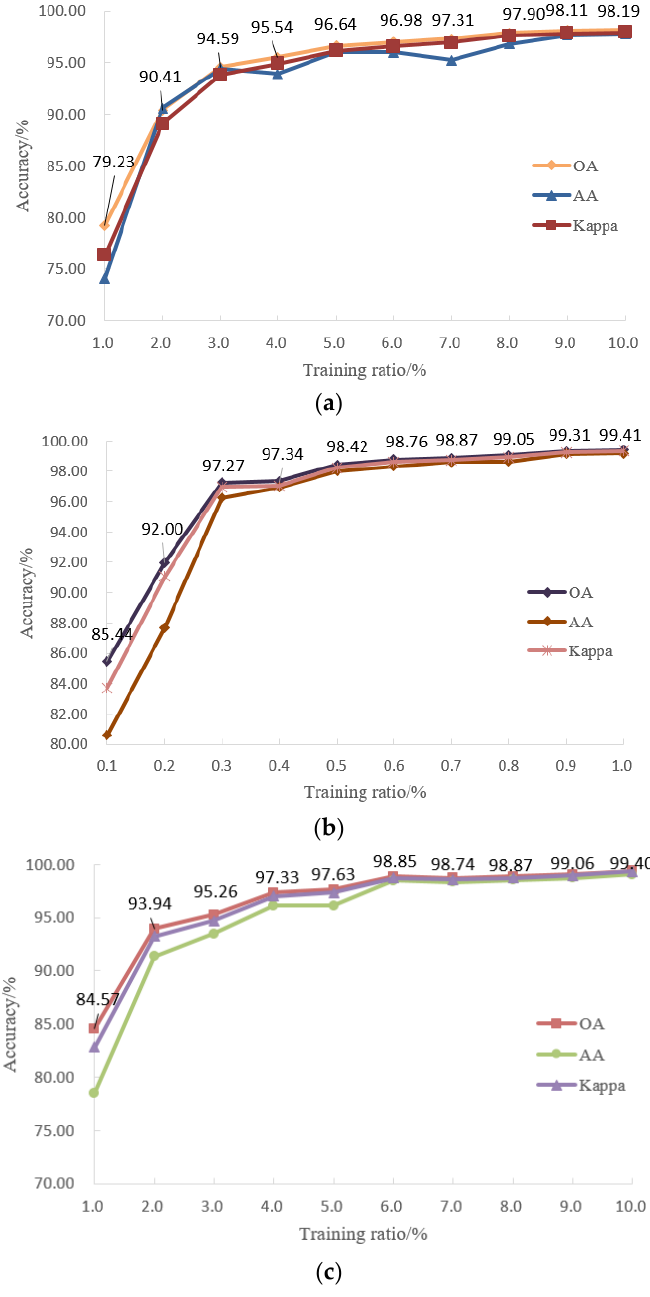
Figure 15. Effect of different training ratios on classification performance ( a ) Indian Pines ( b ) Salinas Valley ( c ) Kennedy Space Center.